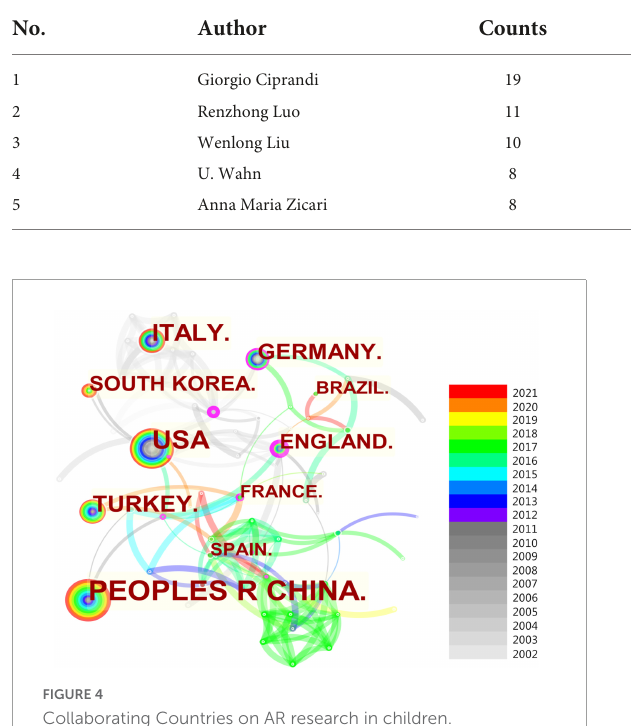
TABLE 1 Top 10 active authors from 2002 to 2021.